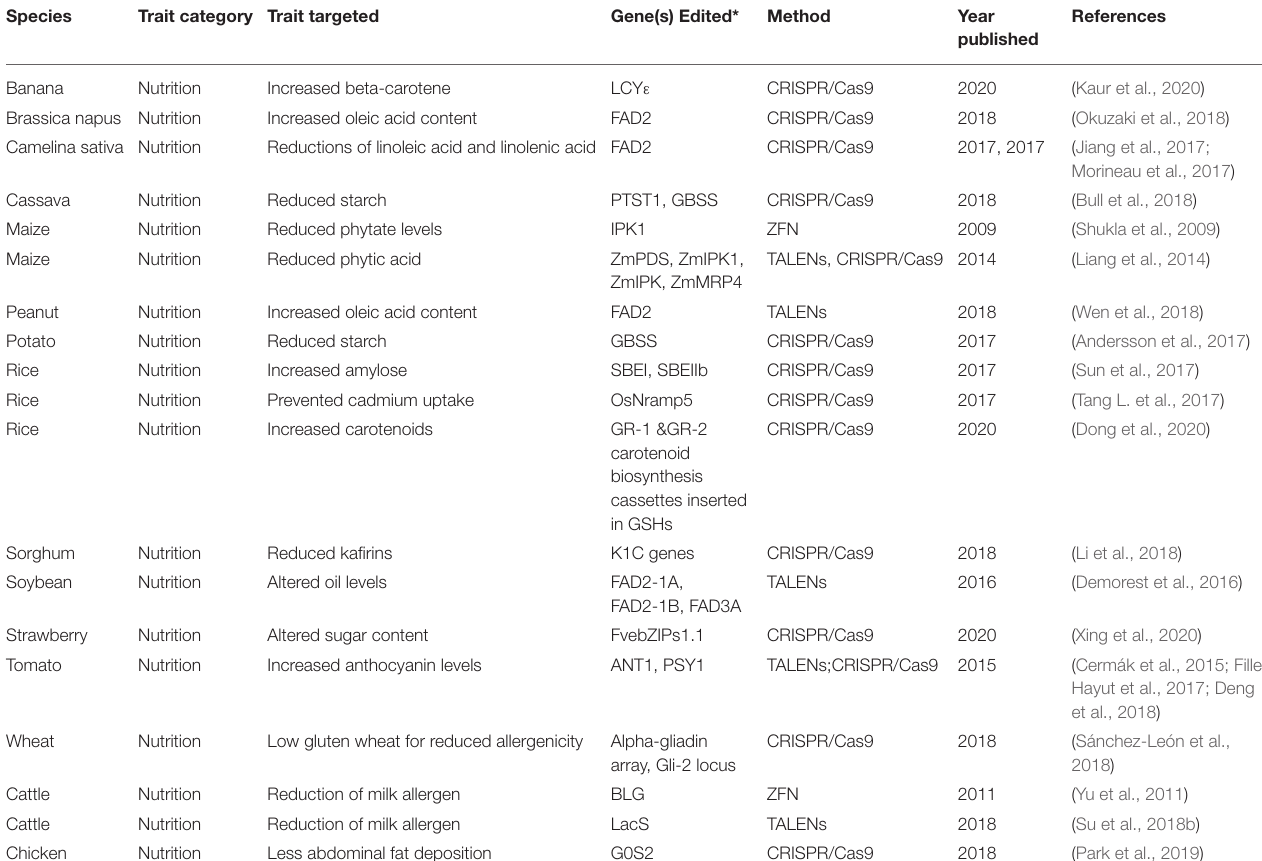
TABLE 4 | Summary of gene-editing applications for